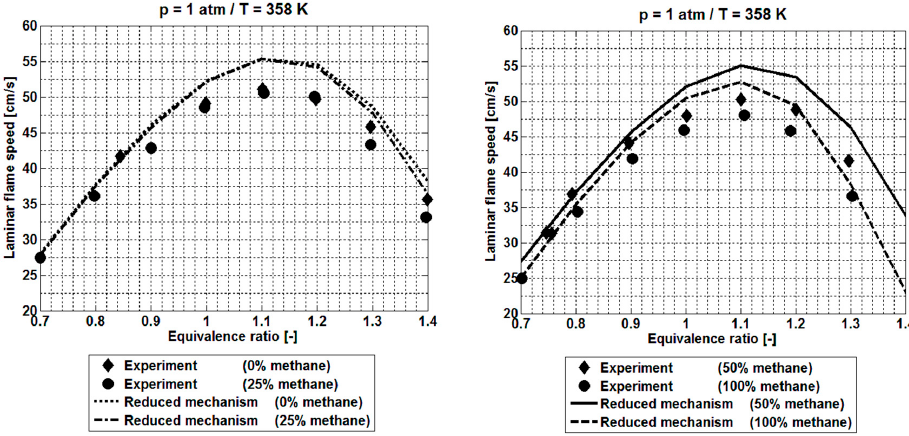
Figure 8. Comparison of laminar flame speed calculations for dual fuel mixtures. The reduced dual fuel mechanism is compared to the experimental data found in [44].